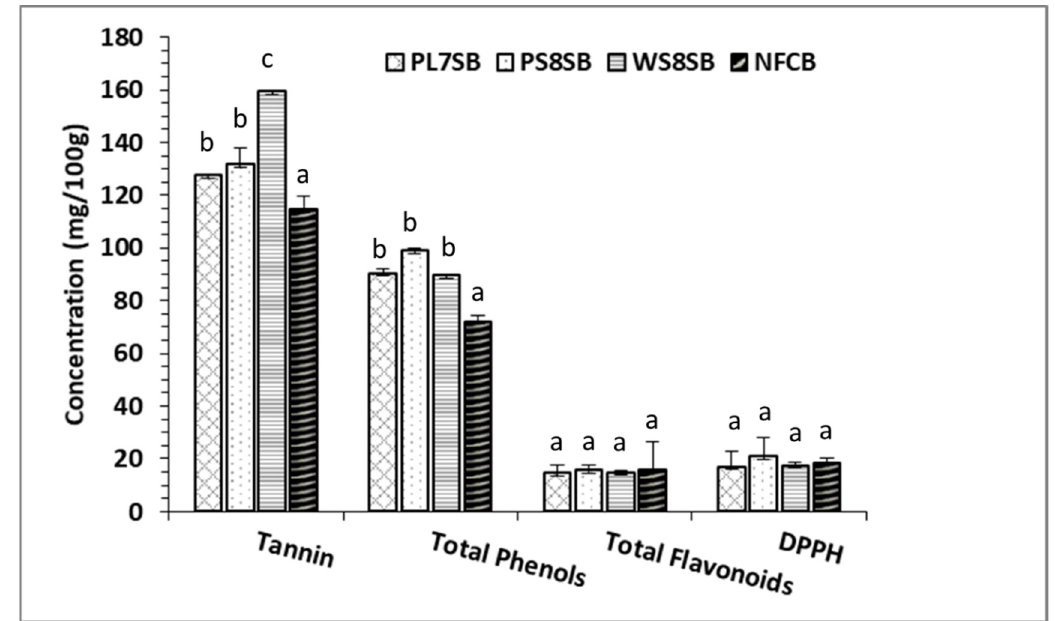
Figure 4. Antioxidants of sourdough breads (SB) obtained with different LAB strains and control bread. Results indicate mean values; error bars indicate standard errors. Different letters (a, b, c) represent significant differences ( p value ˂ 0.05) by Tukey’s test. PL7SB (SB with Pediococcus pentosaceus LD7); PS8SB (SB with Pediococcus pentosaceus SA8); WS8SB (SB with Weissella confusa SD8), NFCB (control bread without sourdough).